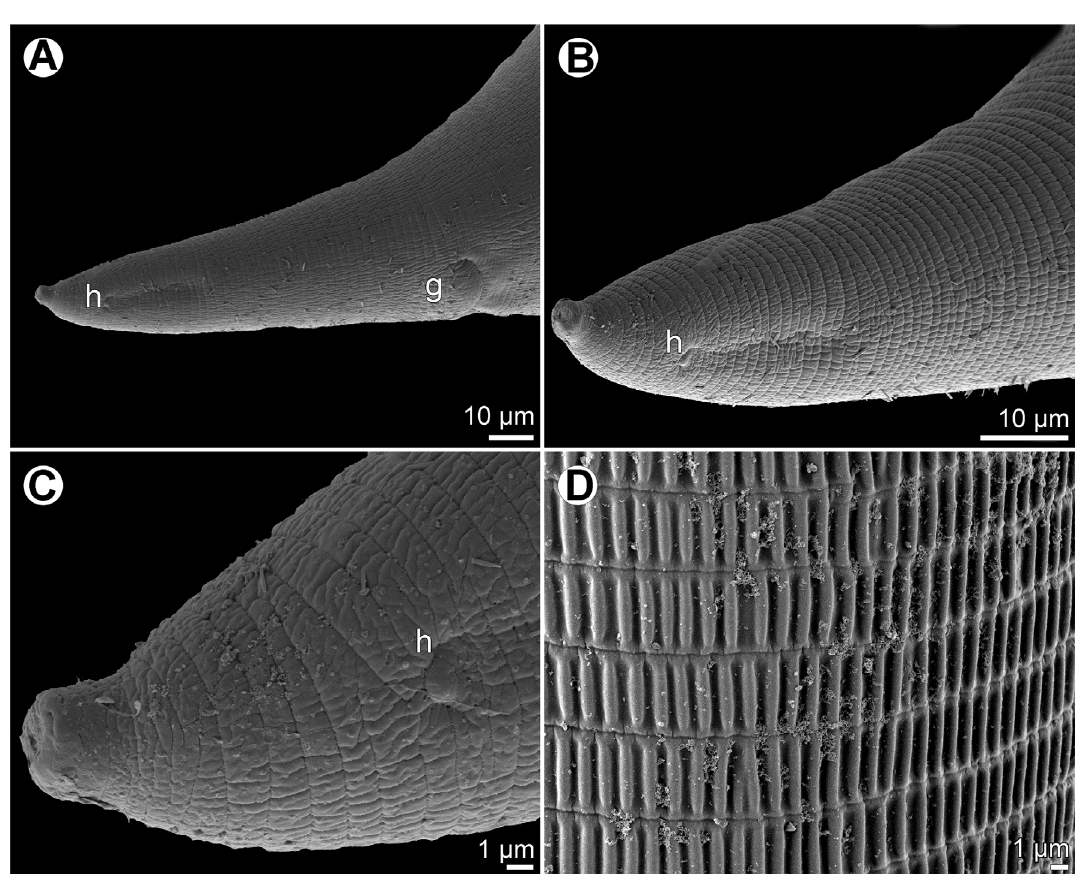
Figure 9. Ascarophisnema tridentatum Moravec et Justine, 2010 from Gymnocranius grandoculis , scanning electron micrographs of female. (A) Tail, lateral view; (B) posterior part of tail, lateral view; (C) tail tip; (D) detail of cuticle at anterior part of body. (g) Anus; (h)